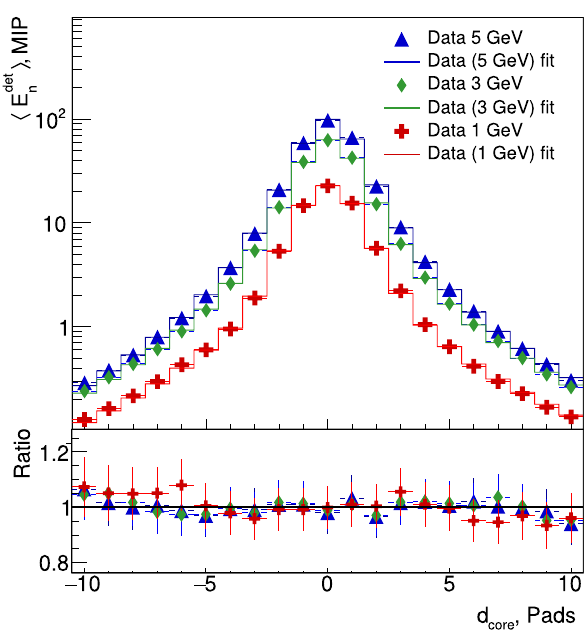
Fig. 21 The average transverse shower profile, (cid:7) E det n (cid:8) , as a function of the distance from the core, d core , in units of the pad dimension (1.8 mm), for data (blue triangles) and MC simulation (red circles). The histograms are the results of fits to data and Monte Carlo simulation to the function in Eq. (12). The distributions are obtained with a 5 GeV electron beam. The lower part of the figure shows the ratio of the distributions to the fitted function, for the data (blue) and simulation (red)